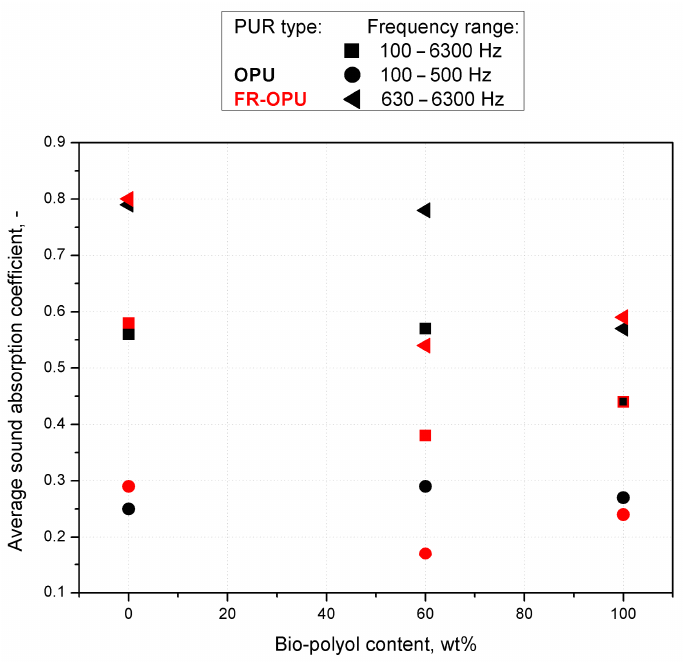
Figure 8. Average sound absorption coe ffi cients of selected polyurethane foams in di ff erent frequency